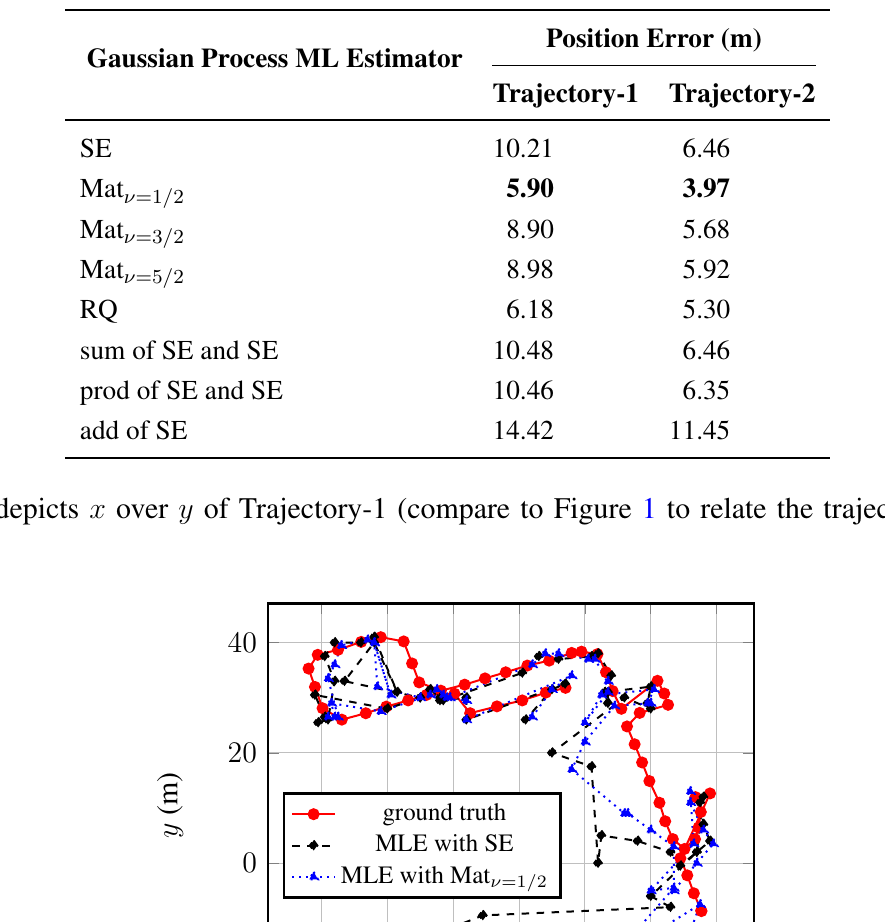
Table 6. Root mean square position error of different position estimators, using the joint radio map, for Trajectory-1 and Trajectory-2. The Gaussian process ML estimators were derived from the Test-bed radio map.